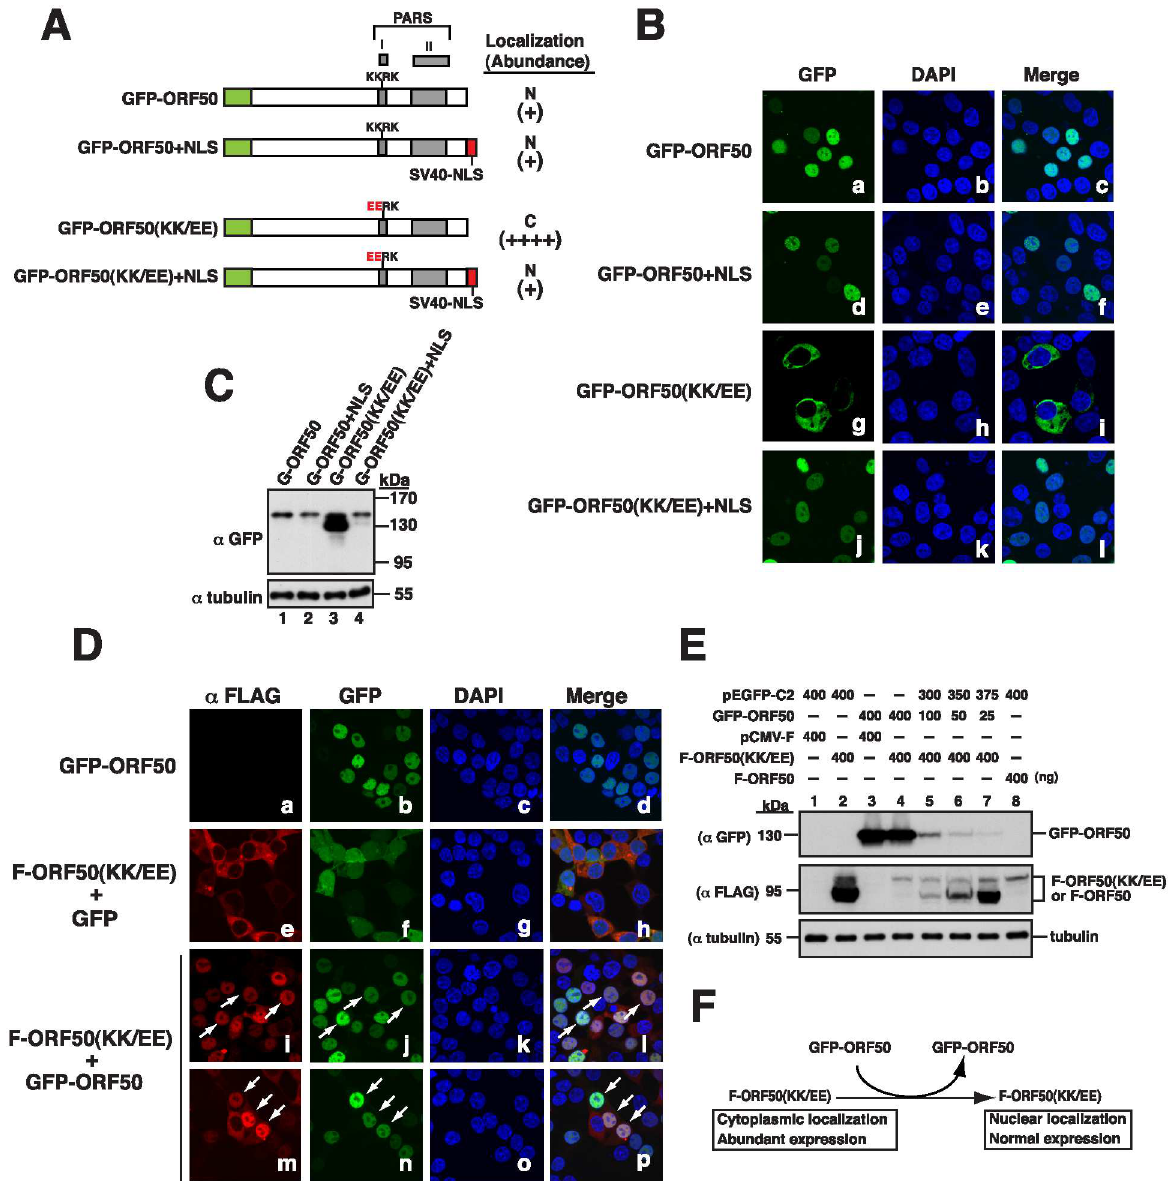
Fig 3. Nuclear translocation of ORF50(KK/EE) and its abundance. (A) Schematic diagram of GFP-ORF50 and GFP-ORF50(KK/ EE) constructs with or without an appendage of the SV40 NLS. The subcellular localizationand protein abundance of each GFP fusion construct determined by confocal microscopy (B) and by immunoblot analysis(C) are summarized. (D) Confocal images of both F-ORF50(KK/EE) and GFP-tagged proteins expressed in 293T cells. Cells were cotransfected with plasmidsexpressingF-ORF50 (KK/EE) and GFP or GFP-ORF50 for 24 hr. Intracellular localizationof F-ORF50(KK/EE) (red) and GFP or GFP-ORF50 (green) in cells was analyzedby confocal microscopy. Arrows indicate the cells expressing both F-ORF50(KK/EE) and GFP-ORF50. (E) Changesin the expression of F-ORF50(KK/EE) by coexpression with GFP-ORF50. Various amounts of the GFP-ORF50 expression plasmid (0, 25, 50, 100 and 400 ng) were cotransfected with 400 ng of the F-ORF50(KK/EE) expressionplasmid into 293T cells. The expression levels of F-ORF50(KK/EE) and GFP-ORF50 in cells were determined by immunoblotting using anti-FLAG and anti-GFP antibody, respectively. The expression of wild-typeF-ORF50 in 293T cells was also includedin the experiment (lane 8). (F) Summary of phenotypicchanges of F-ORF50(KK/EE) in the presence of GFP-ORF50.